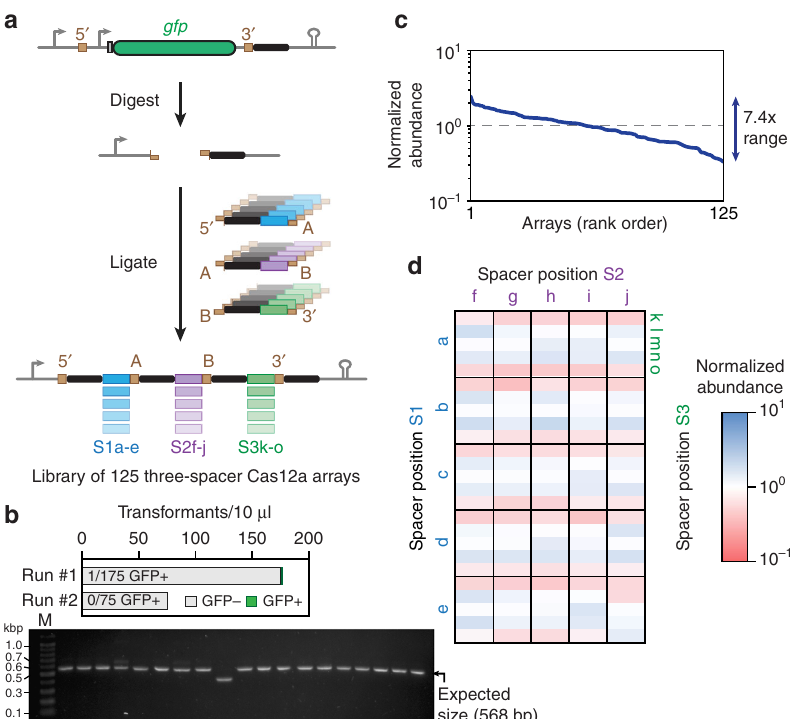
Fig. 2 CRATES can be used to ef fi ciently generate a library of assembled CRISPR arrays in one pot. a Cloning scheme for the CRISPR array library. For this demonstration, a three-spacer array was generated, where each spacer could be one of fi ve unique sequences. The resulting library contains 125 members. Note that the protocol for CRATES was slightly modi fi ed to further improve the cloning ef fi ciency — see Methods. b Two independent libraries were generated followed by counting the number of green and white colonies. Nineteen white colonies from run #2 were then screened by colony PCR. All but one colony gave the expected band size of 528 bp. c Distribution of array abundances within the library from run #2. The distribution was assessed by next-generation sequencing. d Abundances of individual arrays within the 125-member library. The relative abundances are derived from next-generation sequencing results. A value of 1 represents the expected abundance if every library member is equally abundant. Source data are provided as a